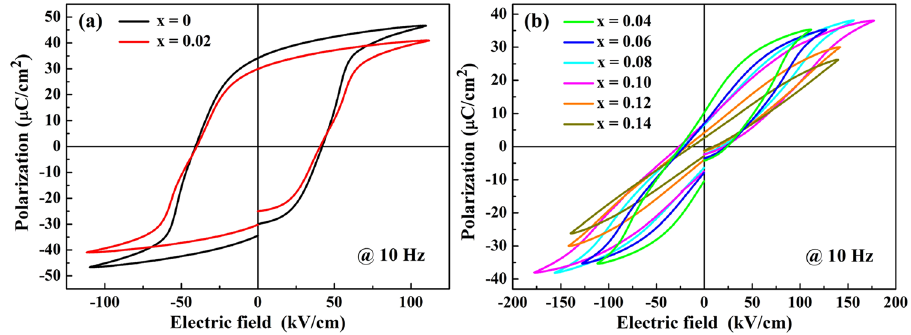
Figure 7. P-E loops of the (1-x)LLBNTZ-xNBN ceramics measured at room temperature: ( a ) x = 0–0.02, ( b ) x =